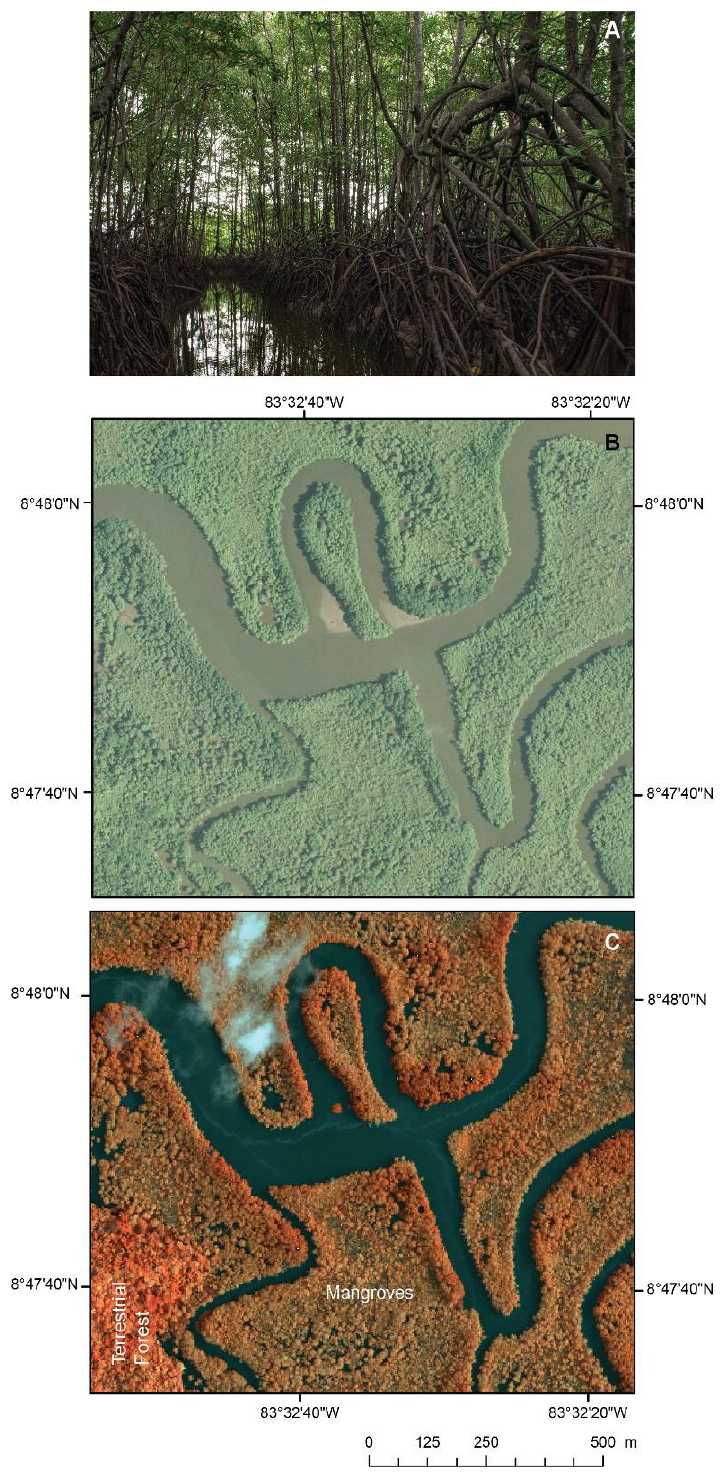
Figure 2. ( A ) Ground photograph from the Sierpe mangroves, ( B ) Subset of the CARTA 2005 aerial photographs from the mangroves, ( C ) Subset of a CASI 1500 HSI (R: 748 nm G: 550 nm B: 519 nm) flight line acquired in 2013 illustrating the same subset of mangroves as seen in B. The delimitation of terrestrial forest and mangroves is more apparent from the HSI than from the aerial photograph.